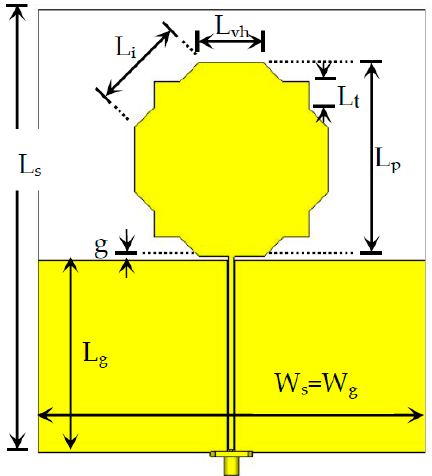
Figure 7. Modified octagonal monopole antenna element with CPW feed. Table 1. Values of the geometrical parameters of the modified octagonal monopole.